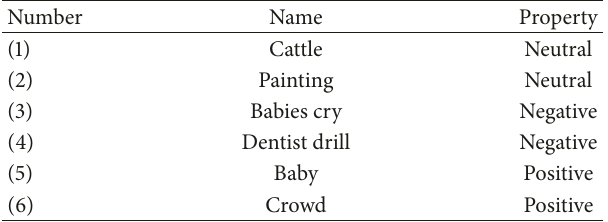
Table 1: Audio stimulation